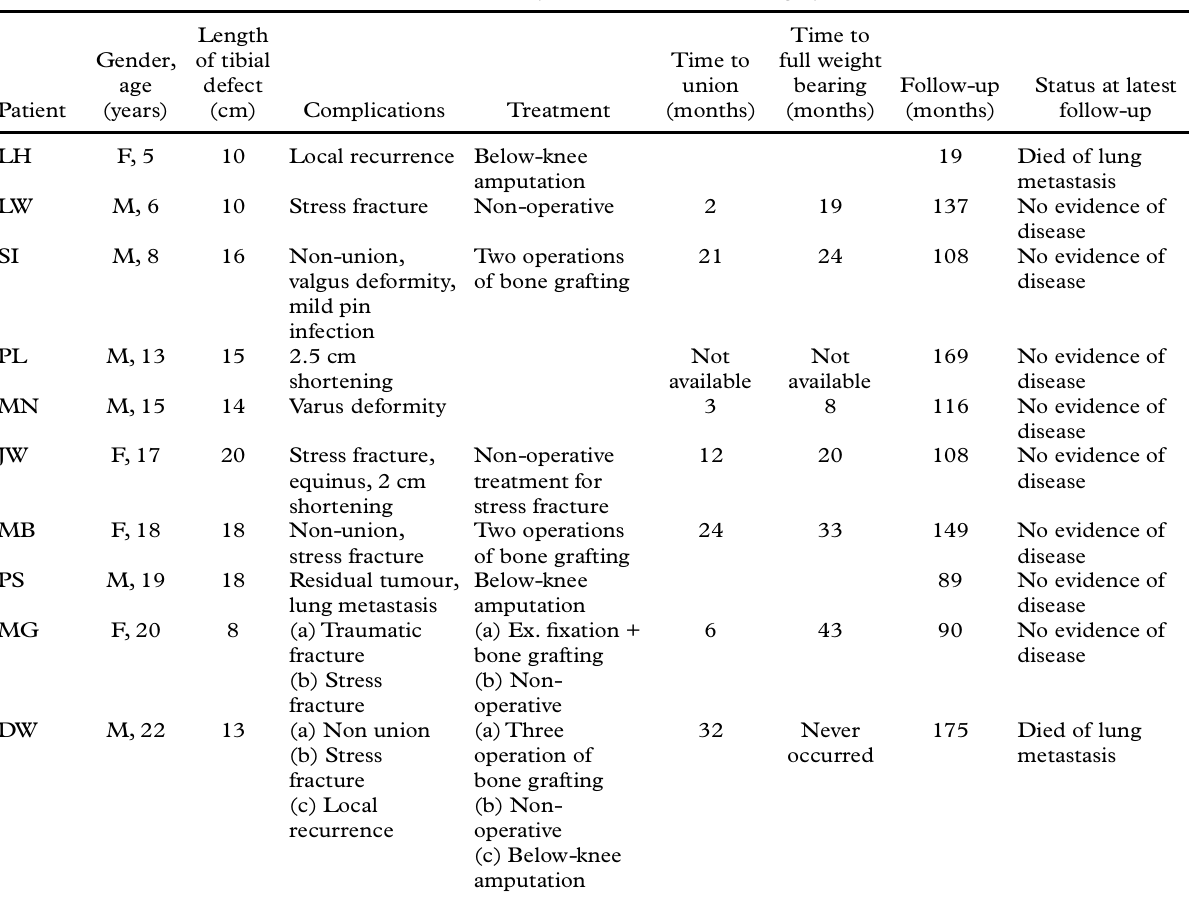
Table 1. Details of 10 patients with ® bular